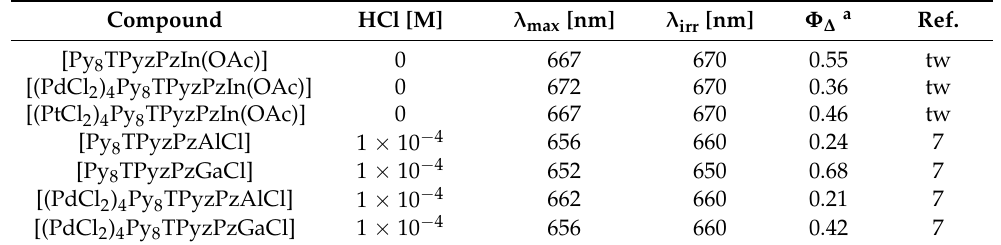
Table 2. Singlet Oxygen Quantum Yields ( Φ ∆ ) in DMF (or DMF/HCl) of [Py 8